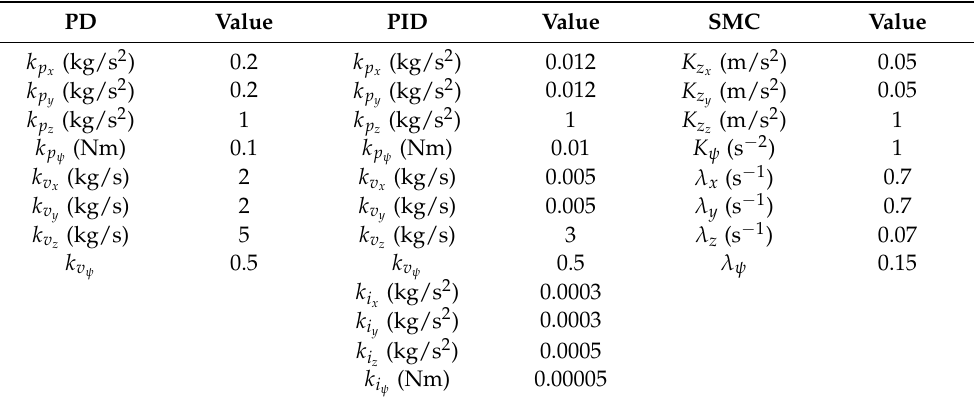
Table 5. Controllers gains for the simulation of the